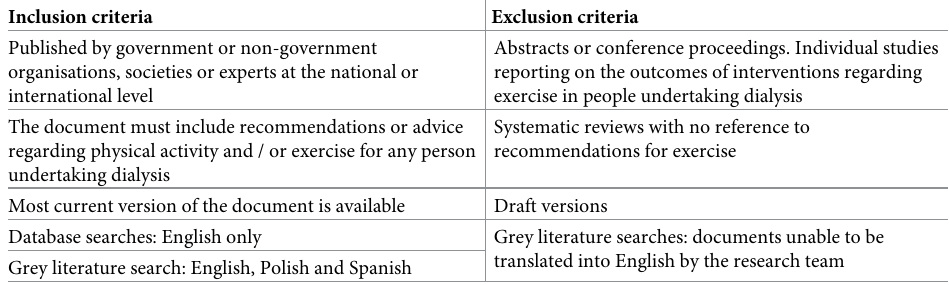
Table 1. Scoping review eligibility